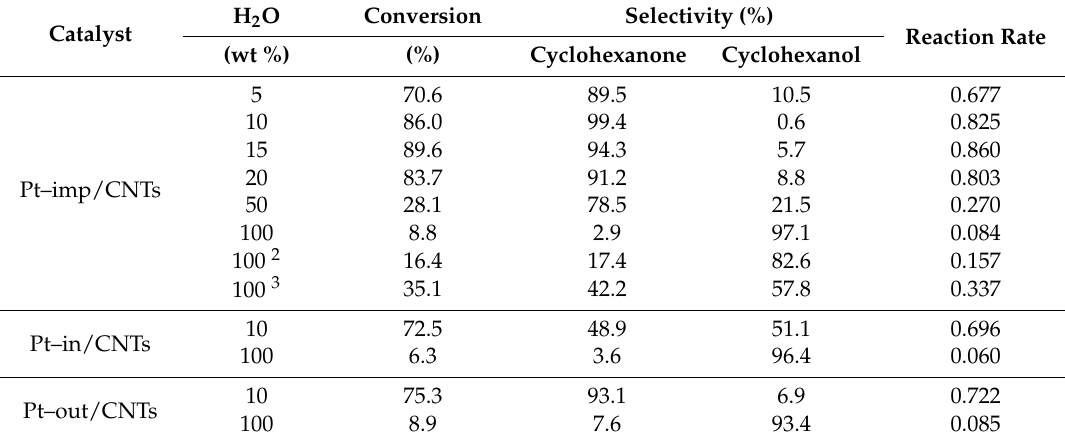
Table 4. Effect of dichloromethane–water mixture on hydrogenation of phenol over Pt–in/CNTs, Pt–imp/CNTs, and Pt–out/CNTs 1 .